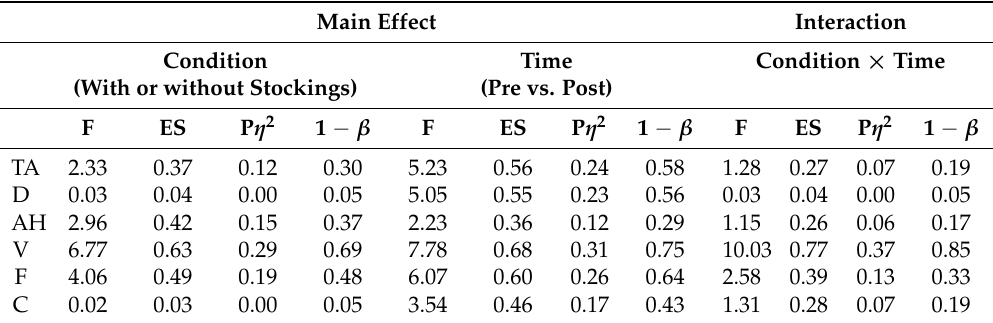
Table 2. Summarized results of statistical analysis for profile of mood